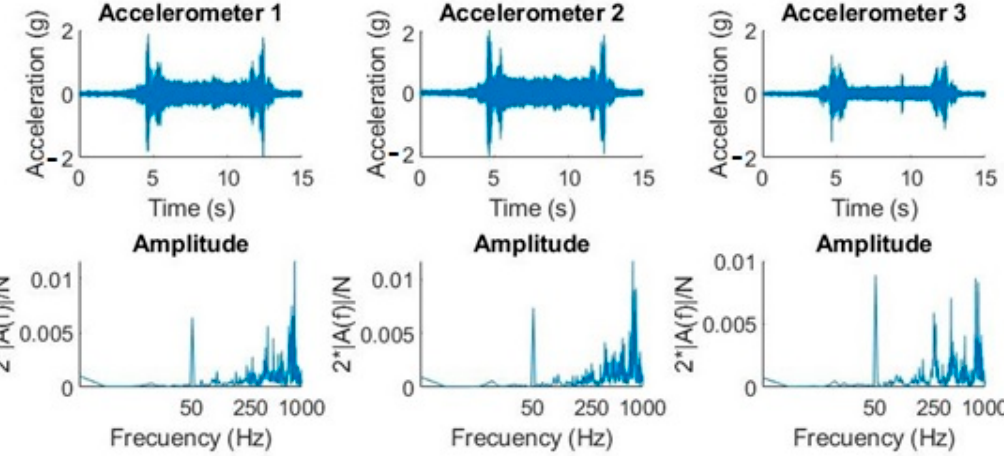
Figure 8. Graphs (acceleration-time and amplitude-frequency) with the three accelerometers in a straight ascension movement at 40° and declination at 0°.